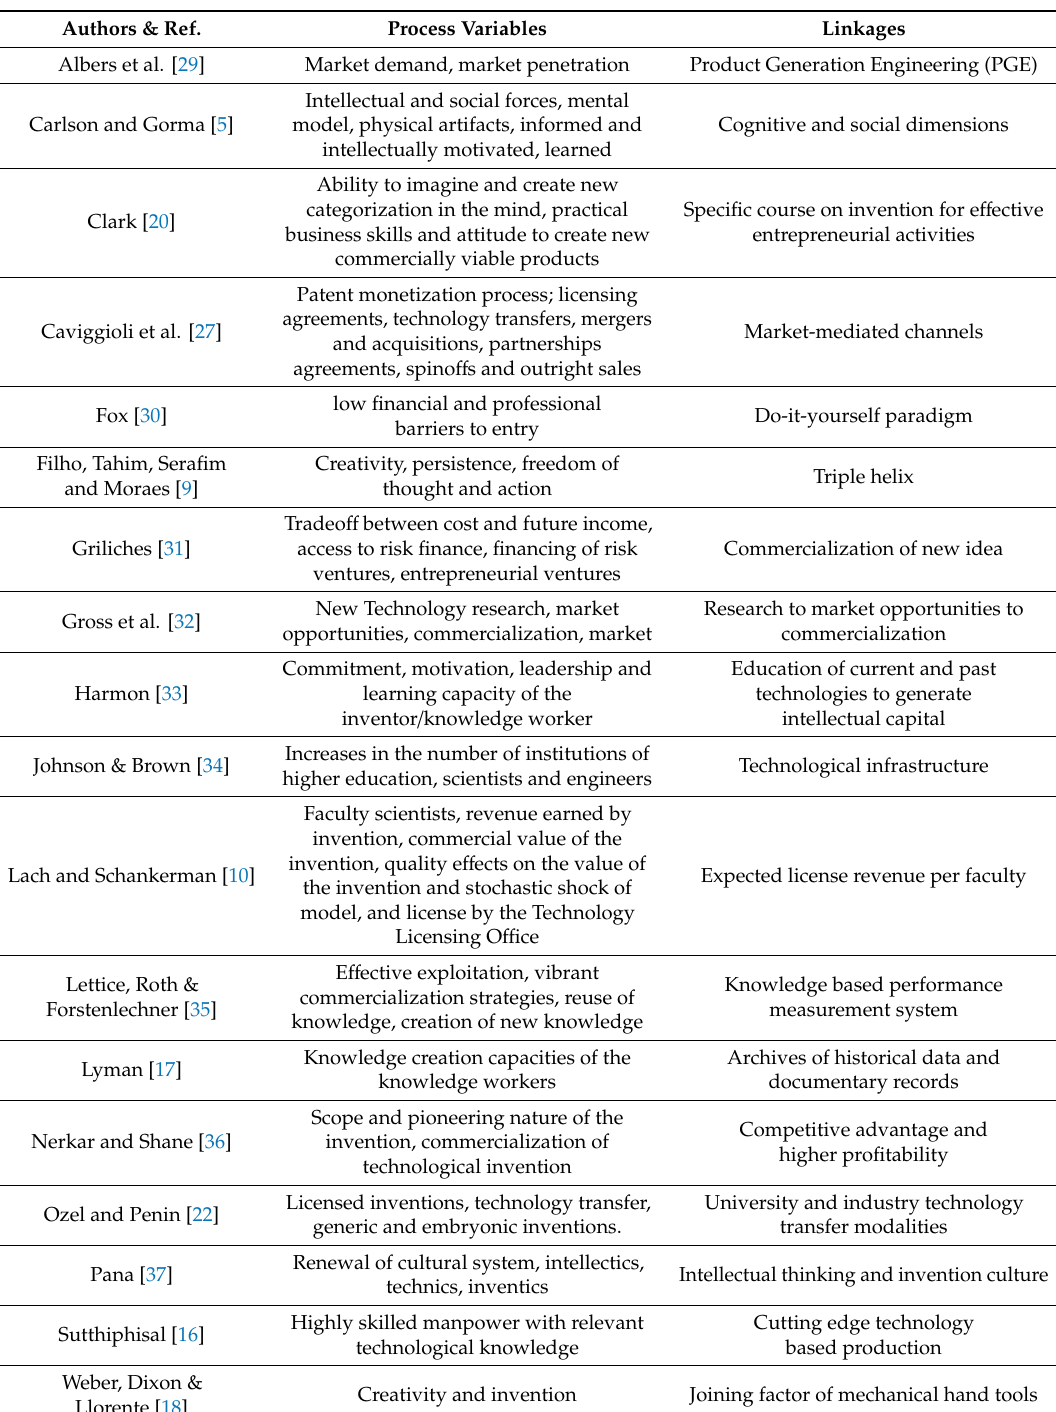
Table 1. Invention processes and